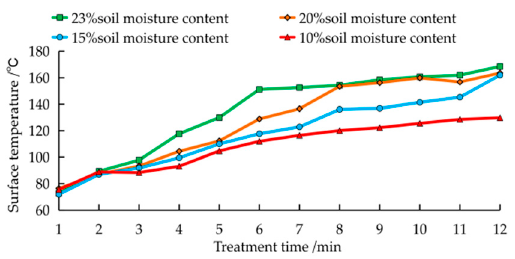
Figure 13. Surface temperature of loess irradiated by microwaves.